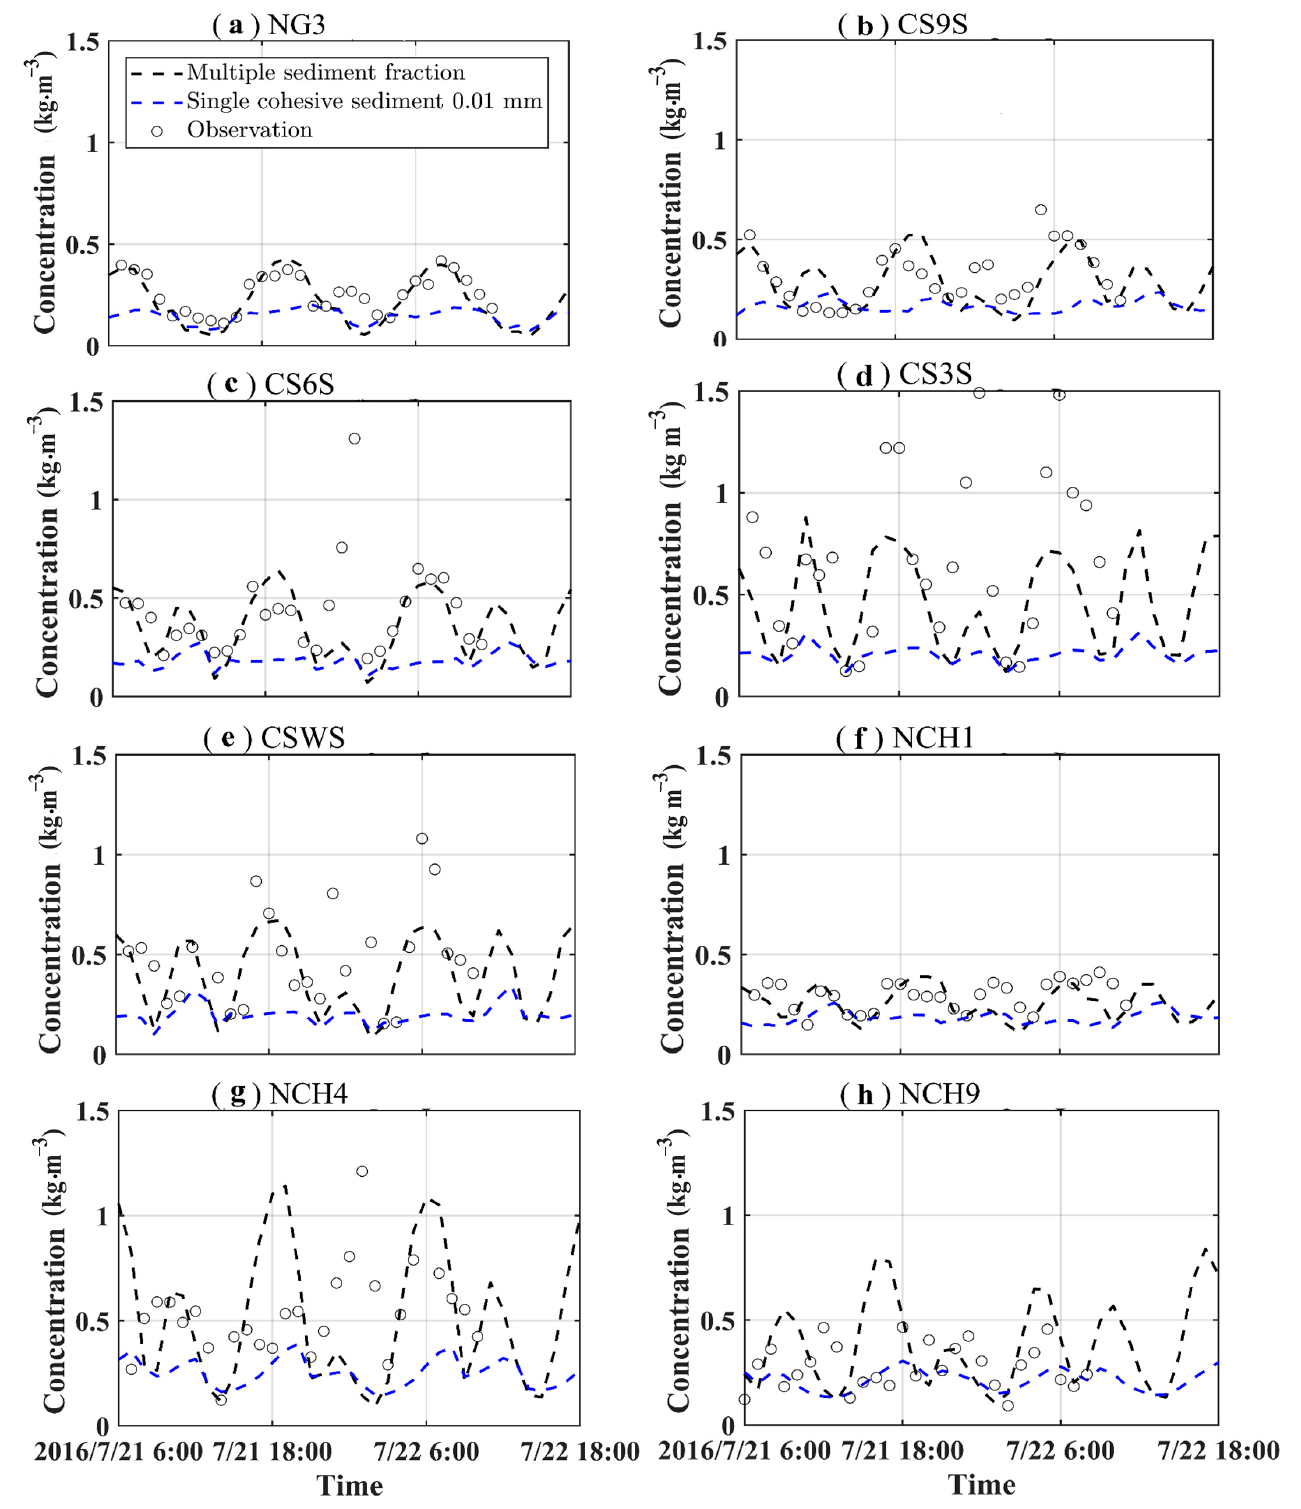
Figure 10. Comparison of simulated and measured SSC during spring tide under the different bed sediment composition, and subfigures ( a – h ) represent the comparison results at 8 stations for SSC shown in Figure 3b, respectively.